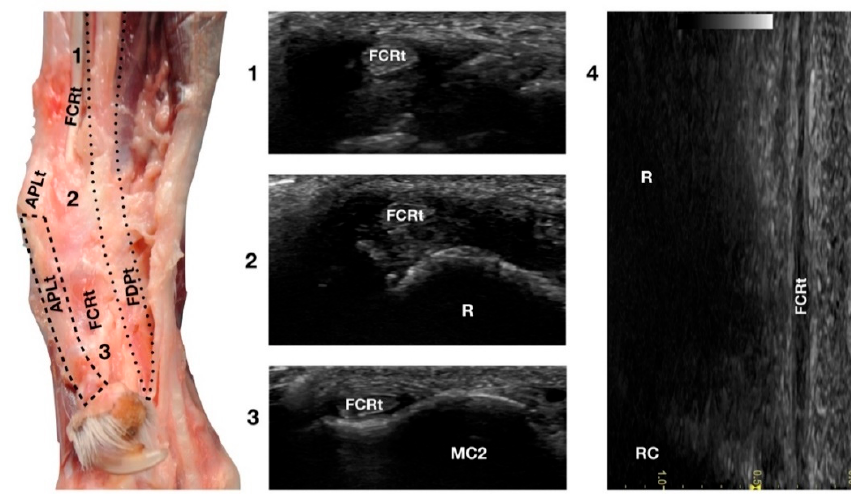
Figure 9. Palmaromedial carpal face centred on the Flexor Carpi Radialis (FCR) tendon. At the ulnar notch (2), the FCRt is a thin, relatively hypoechoic, oval structure surrounded by ill-defined and hypoechoic muscle fibres. Proximally, at the tenomuscular junction (1), the tendon is relatively superficial and better defined from the surrounding hypoechoic muscles. The radial surface is visible (R). At the level of the carpometacarpal joints, the tendon splits into two equal parts and becomes closer to the osseous surface of the base of metacarpal bone 2 or 3 (in this case it is MC2) where it terminates (3). On the longitudinal scan (4) obtained by aligning the probe to the palmar margin of the ulnar notch, the thin FCRt is seen as a hypoechoic structure with few visible fibrillar lines. The radial (R) and radiocarpal (RC) surfaces beneath are